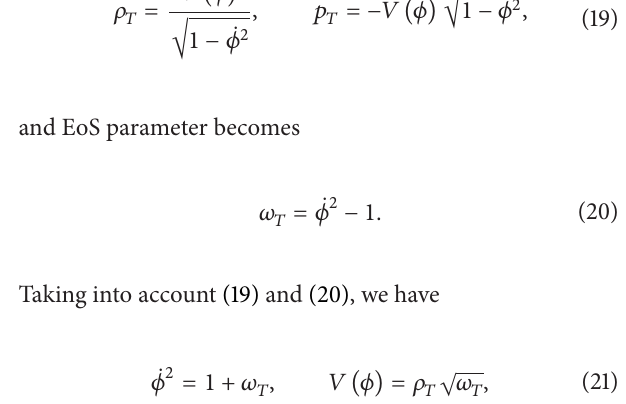
on, particularly for greater value of 𝑛 . The increasing value of scalar field indicates that kinetic energy is decreasing. The potential function versus time in plot (b) expresses decreasing behavior. The plot of quintessence potential in terms of scalar field is shown in Figure 3 representing increasing